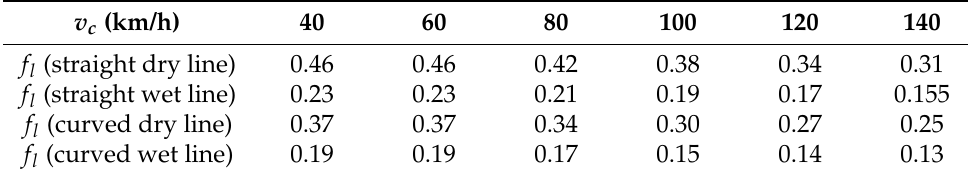
Table 1. Some values of f l vs v c used in this